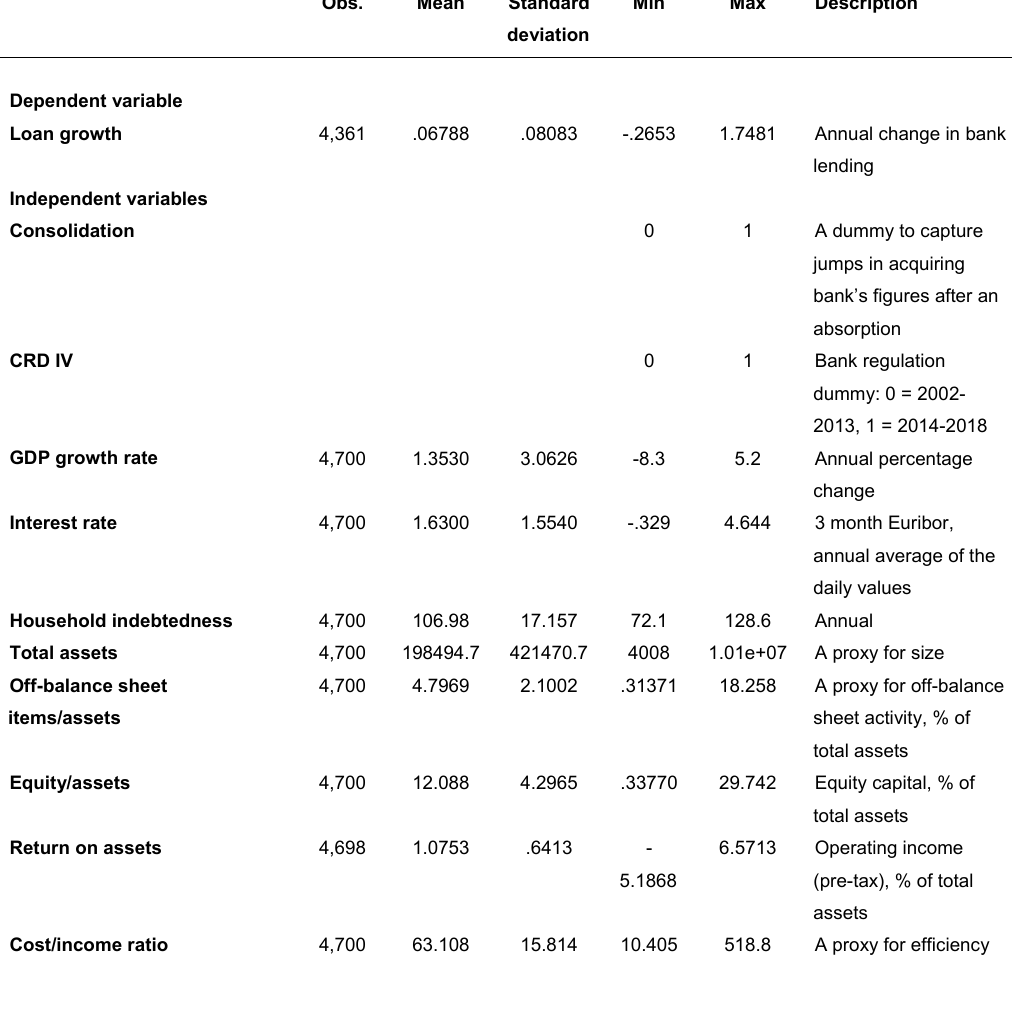
Table 2. Variables and descriptive